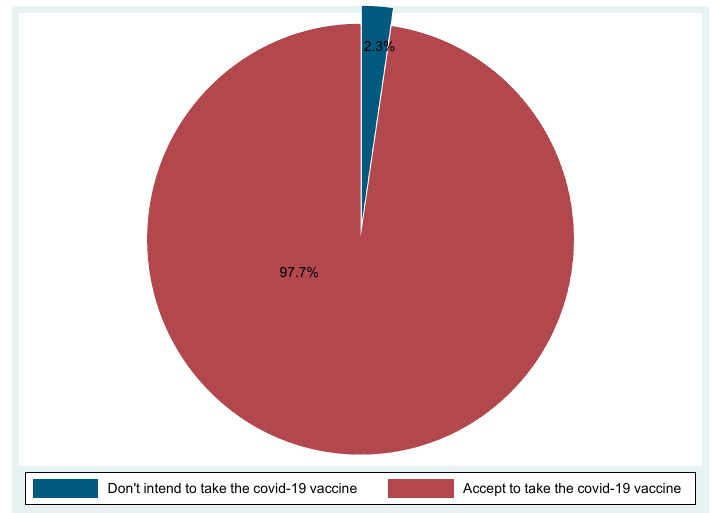
Figure 1. Acceptance/intention to receive COVID-19 vaccine.